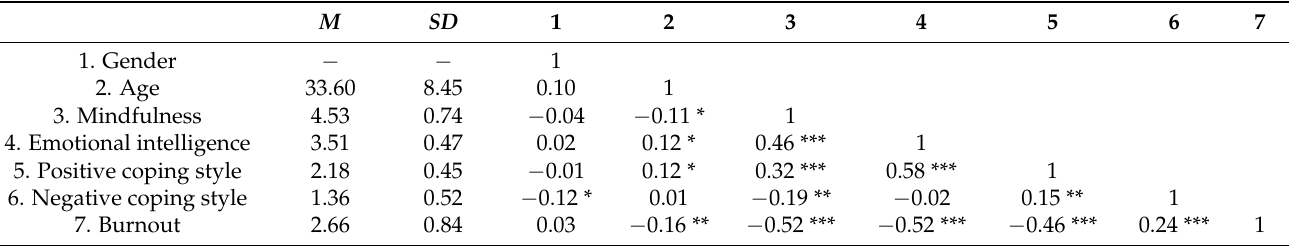
Table 1. Correlations and descriptive statistics of measured